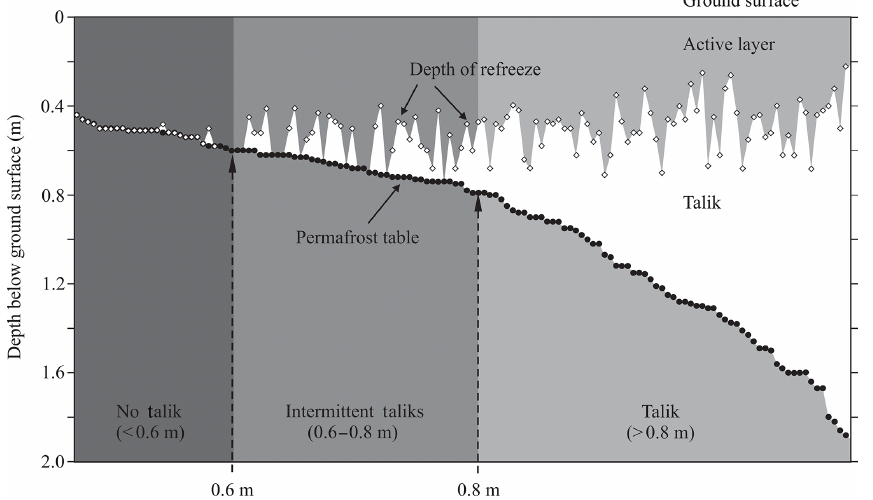
Figure 5. Suprapermafrost layer thickness measurements ranked from thinnest (left) to thickest (right) and associated thaw depth measure- ments. Active layer refreeze depth was measured in April 2016, following thaw depth measurements in August 2015. Modified from Connon et al. (2018a).